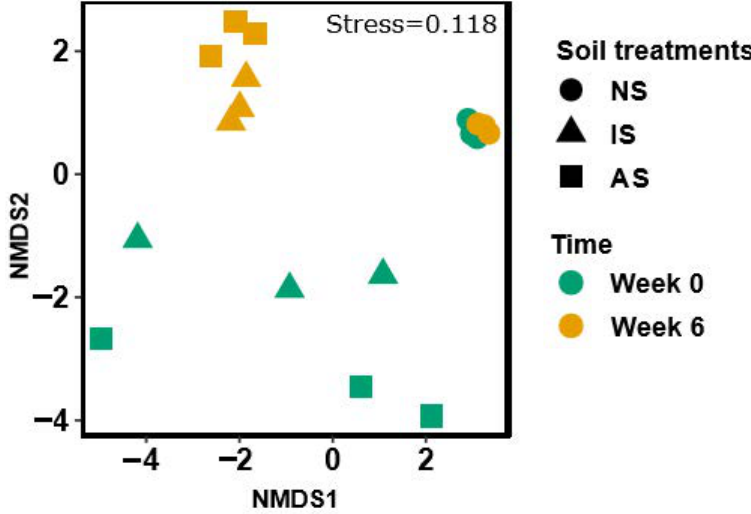
Figure 4. Variations in bacterial communities among soil samples (NS: natural soil, IS: inoculated soil, and AS: autoclaved soil) with natural maize litter displayed in nonmetric multidimensional scaling (NMDS) of Bray–Curtis dissimilarity (n = 3). Circle, triangle, and square shapes stand for NS, IS, and AS. Green and yellow colors represent the time points when maize litter was applied (week 0) and 6 weeks after the litter application,